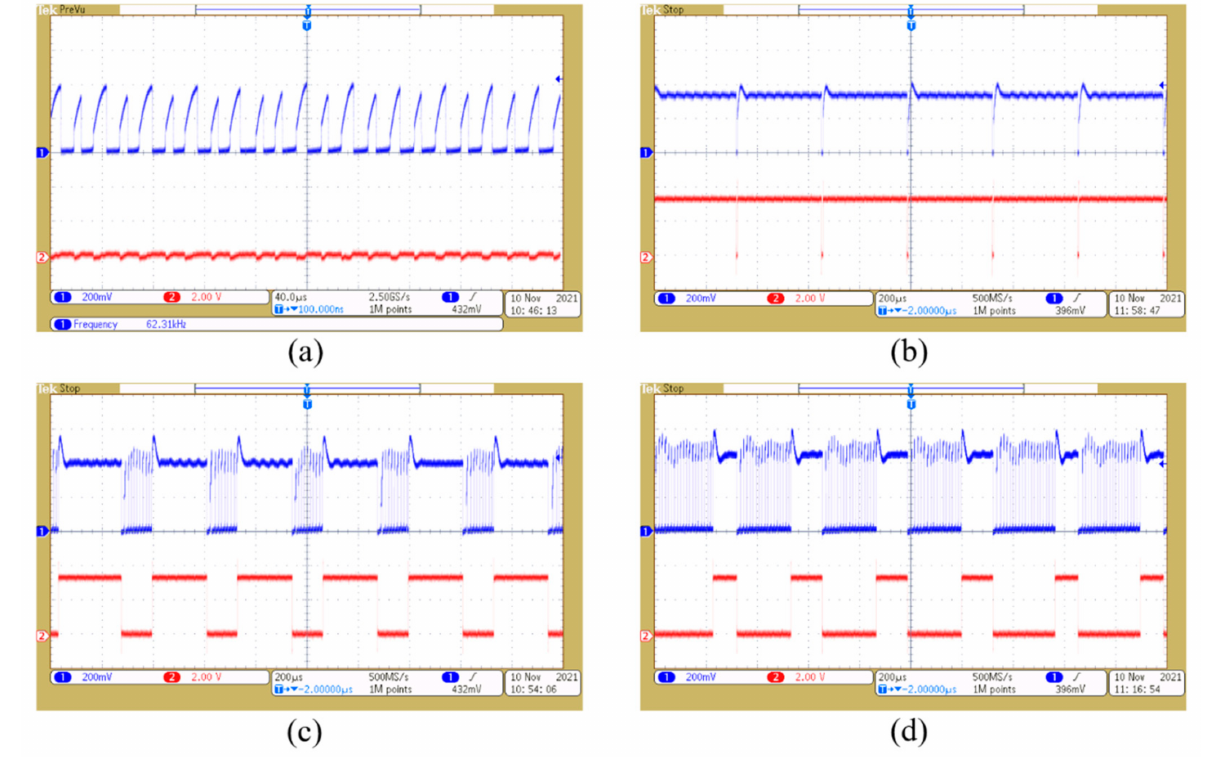
Figure 11. The DC/DC converter voltage oscillograms measured on collector of switching transistor and on gate of control transistor for PWM signal: ( a ) disabled, ( b ) for R o = 100 Ω , ( c ) R o = 200 Ω , ( d ) R o = 500 Ω .